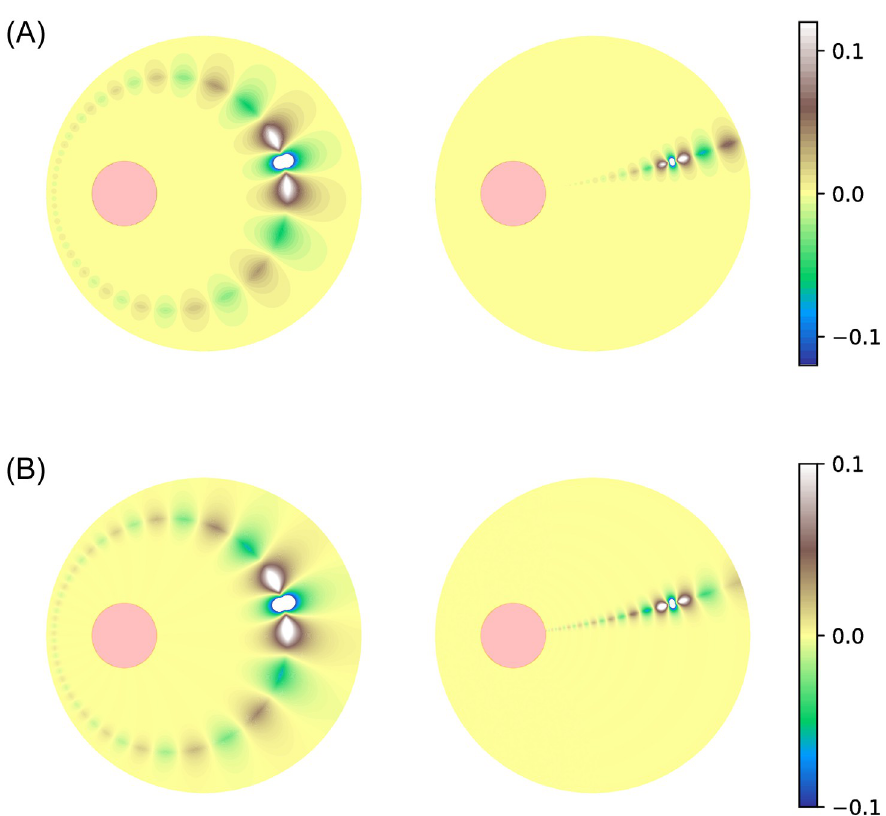
Fig 3. Dependence of truncation errors in Green’s functions on position x. The inclusion is the red disk, displaced by ( − 0.5, 0) with respect to the centre of the unit circle, and the initial position x 0 of the diffusing particle, is displaced by (0.5, 0.2). Upper left: G